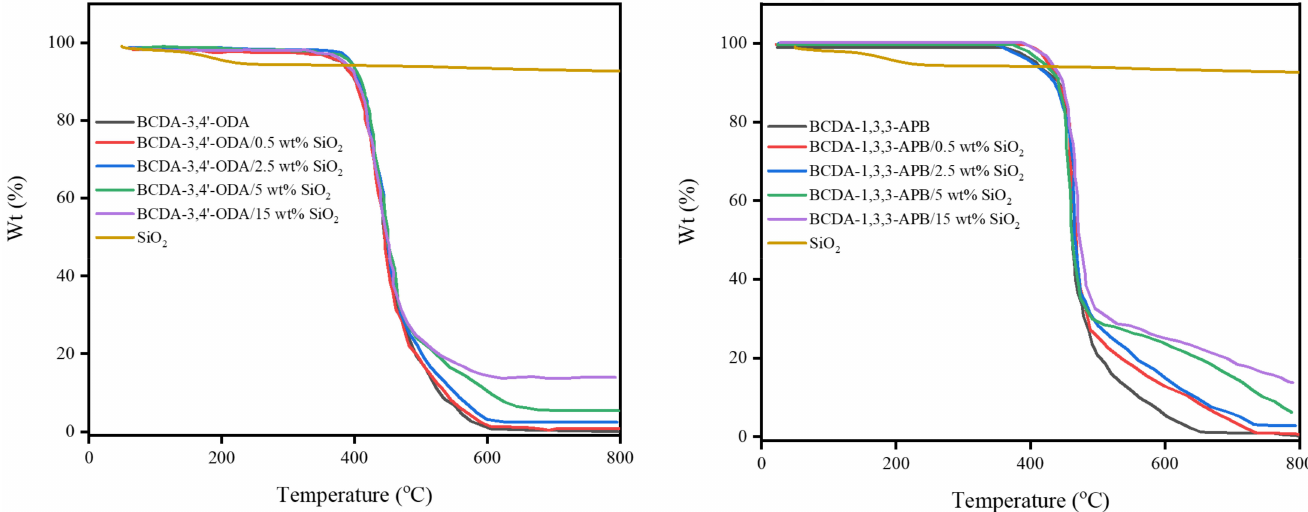
Figure 4. TGA results of pristine alicyclic PI membranes and their related PI/SiO 2 mixed matrix membranes.